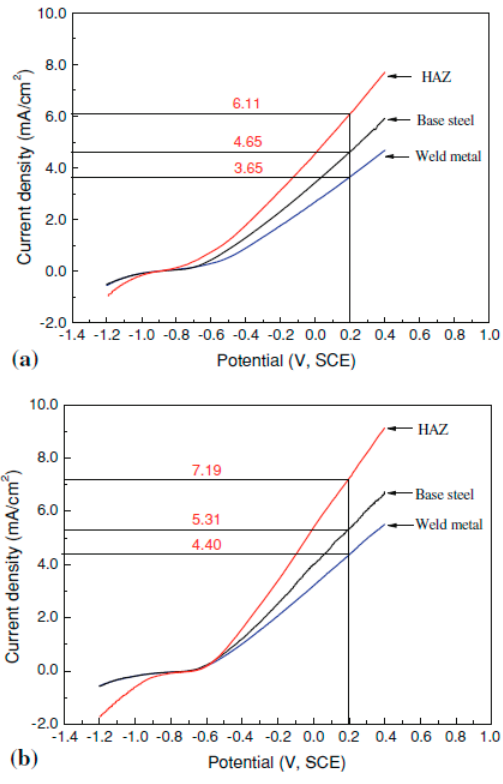
Figure 10. Polarization curves measured at various zones of the weld in NS4 solution in the absence ( a ) and presence ( b ) of hydrogen-charging at cathodic current density of 10 mA/cm2 for 2 h [73].